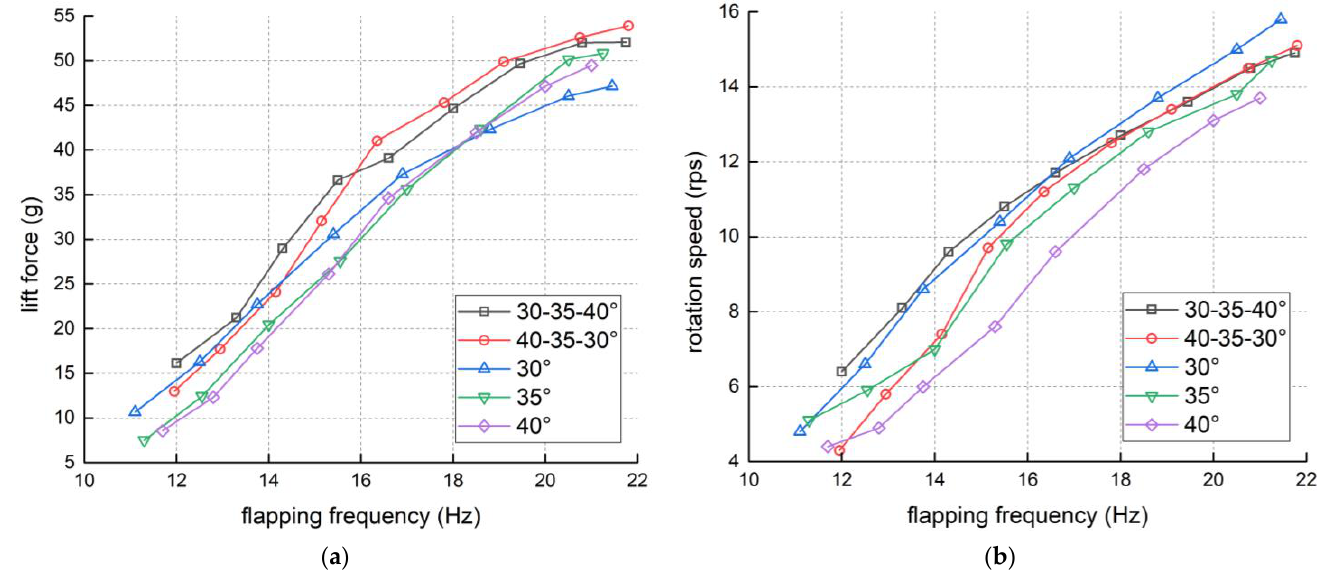
Figure 15. The influence of 5° wing torsion of the FWR: ( a ) Flapping frequency-lift force line chart; ( b ) flapping frequency-rotation speed line chart.